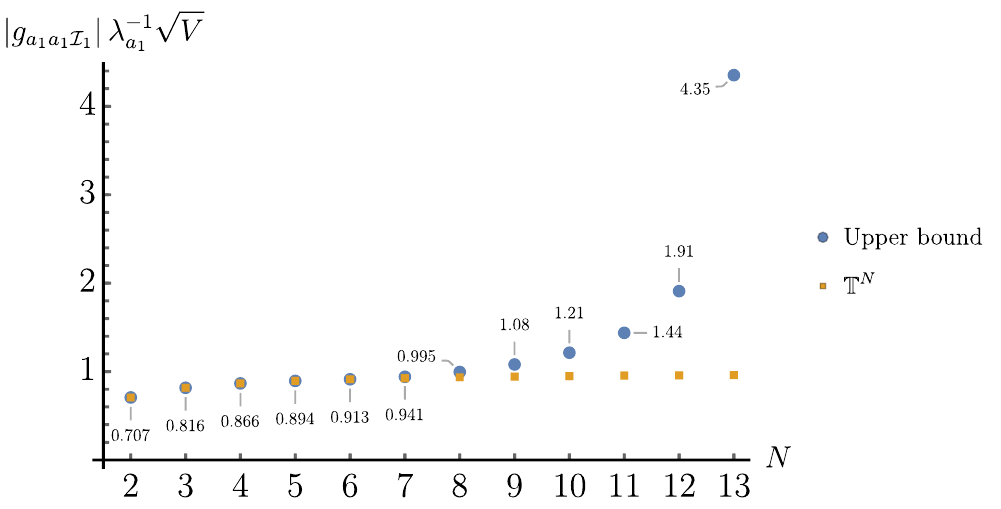
p j (cid:21) (cid:0) 1 V for closed Einstein manifolds with R (cid:21) 0 a 1 1 a 1 I 1